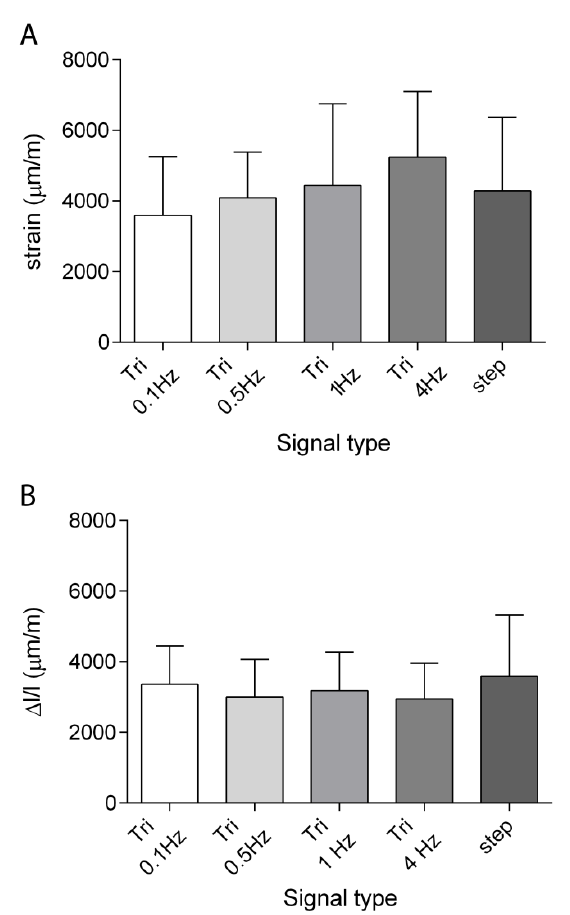
Figure 6. Means ± SDs of the longitudinal strains measured by DIC ( A ) and of the global shortening measured with the length transducer ( B ). n = 5.